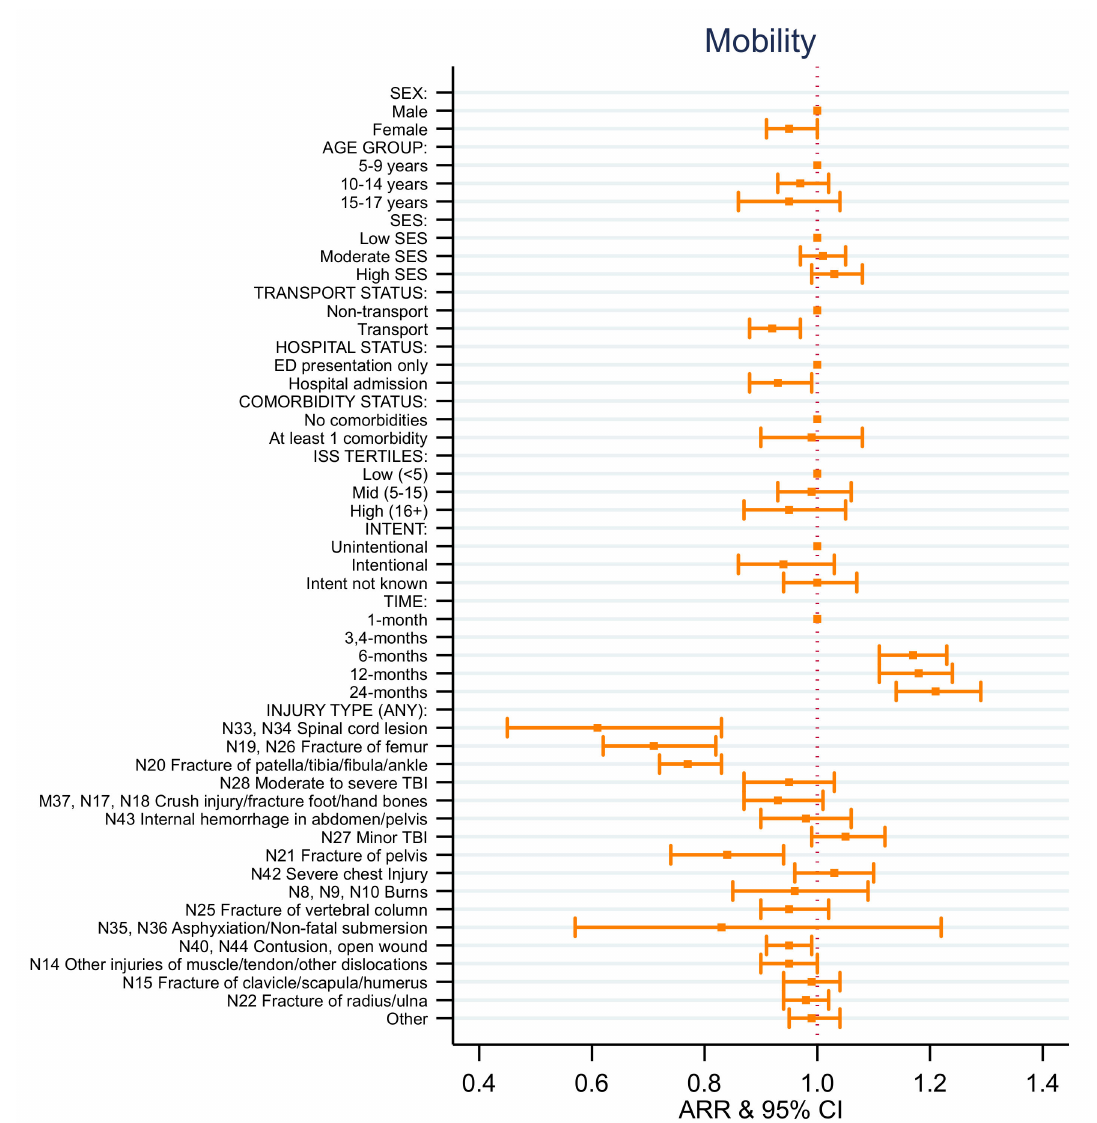
Figure 4. EQ-5D mobility adjusted relative risk